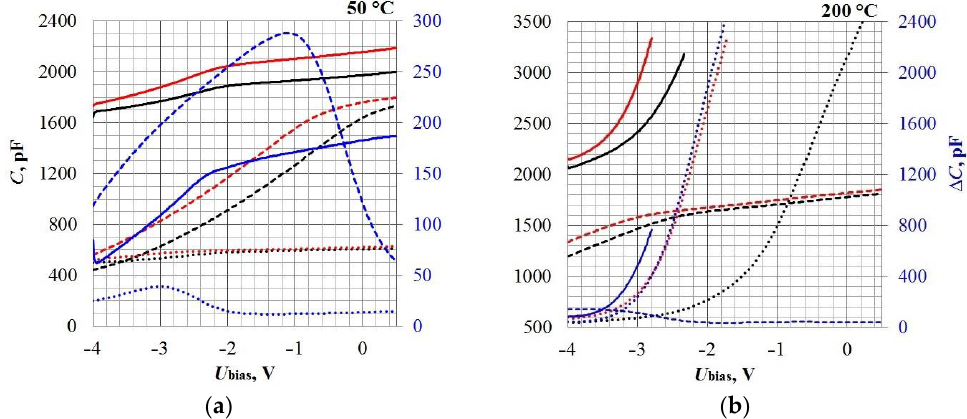
Figure 4. Sensors ’ CV characteristics in the air (black lines) and under the act of 1000 ppm H₂ (red Figure 4. Sensors’ CV characteristics in the air (black lines) and under the act of 1000 ppm H 2 (red lines) at different operating temperatures: 50 °C ( a ) and 200 °C ( b ), taken by using Board CDC. The lines) at different operating temperatures: 50 ◦ C ( a ) and 200 ◦ C ( b ), taken by using Board CDC. The blue lines indicate the sensors ’ responses ΔC(U bias ) corresponding to the CV characteristics ’ shift blue lines indicate the sensors’ responses ∆ C(U bias ) corresponding to the CV characteristics’ shift and plotted on the auxiliary axis. Dotted lines — Sample No. 1; solid lines — Sample No. 2; and dash and plotted on the auxiliary axis. Dotted lines—Sample No. 1; solid lines—Sample No. 2; and dash lines — Control sample. lines—Control